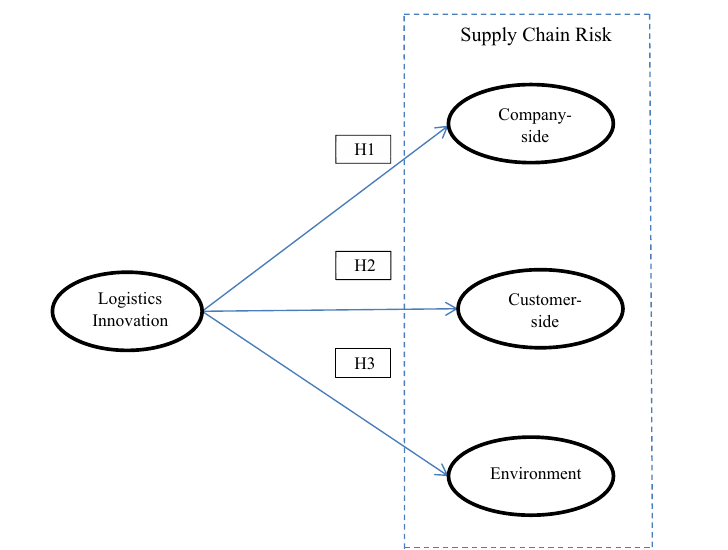
Figure 1. Research